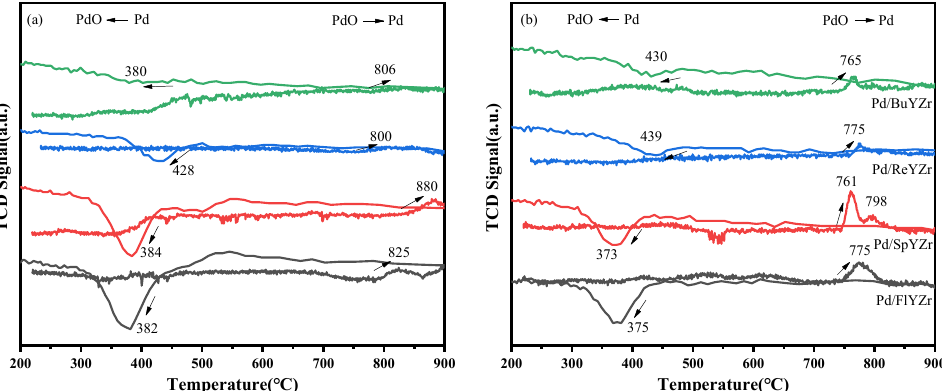
Figure 7. O 2 -TPO spectra of fresh ( a ) and aged ( b) Pd/Y-ZrO 2 catalysts with different morphologies. In order to further understand the chemical state of palladium species on the surface of Pd/Y-ZrO 2 with different morphologies, XPS measurement was carried out, and the results are shown in Figure 8. There are six electron binding energy peaks in the Pd 3d XPS spectrum of the Pd/Y-ZrO 2 . Two signals around 336.6 eV and 342.4 eV are attributed to the characteristic peaks of Pd 2+ 3d 5/2 and Pd 2+ 3d 3/2 , respectively. The other respective signals of 335.5 eV and 341.6 eV are attributed to the characteristic peaks of Pd 0 3d 5/2 and Pd 0 3d 3/2 , respectively. In addition, the peaks with bond energies around 332.6 eV and 346.3 eV are attributed to the characteristic peaks of Zr 3p 3/2 and Zr 3p 1/2 , respectively [40]. The relative percentage of Pd species can be obtained by the area ratio of the Pd 2+ 3d 5/2 and Pd 0 3d 5/2 peaks, as shown in Table 3. It can be seen that the Pd 2+ content of the flower-like, spherical, and bulk catalysts are relatively low, indicating that the active metal Pd in the Pd/FlYZr, Pd/SpYZr, and Pd/BuYZr catalysts are hard to be oxidized [41]. After aging, the relative percentage of Pd 2+ on the surface of Pd/FlYZr, Pd/SpYZr, Pd/ReYZr, and Pd/BuYZr catalysts decreased significantly due to the PdO decomposed into metallic Pd 0 under high temperature. The interaction between Pd and Y x Zr 1 − x O 2 is weakened, thereby promoting the decomposition of PdO.